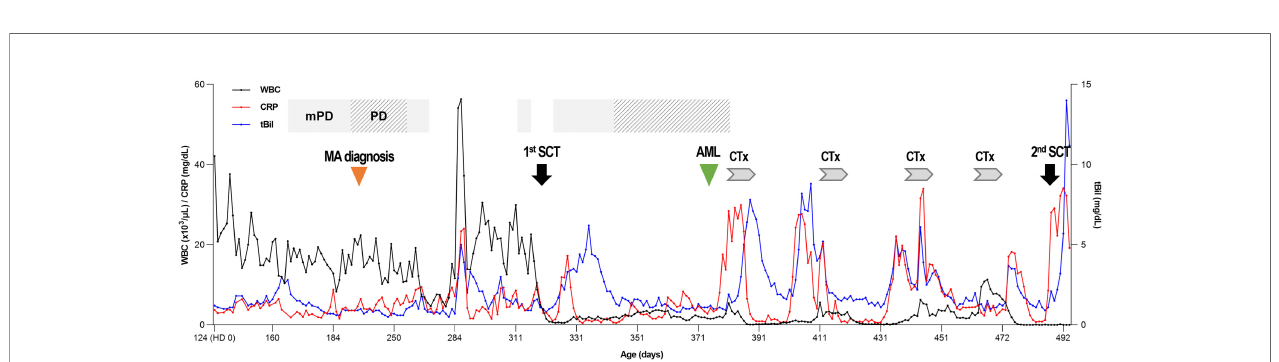
FIGURE 2 | Clinical course of the patient. At the time of diagnosis, leukocytosis was prominent, and CRP was above the normal range. After the 1 st HCT, the WBC count was normalized, and CRP and total bilirubin levels decreased to a normal range and showed alternate increases and decreases during chemotherapy. WBC, white blood cell; CRP, C-reactive protein; tBil, total bilirubin; mPD, methylprednisolone; PD, prednisolone; MA, mevalonic aciduria; HCT, hematopoietic stem cell transplantation; AML, acute myeloid leukemia; CTx, chemotherapy.